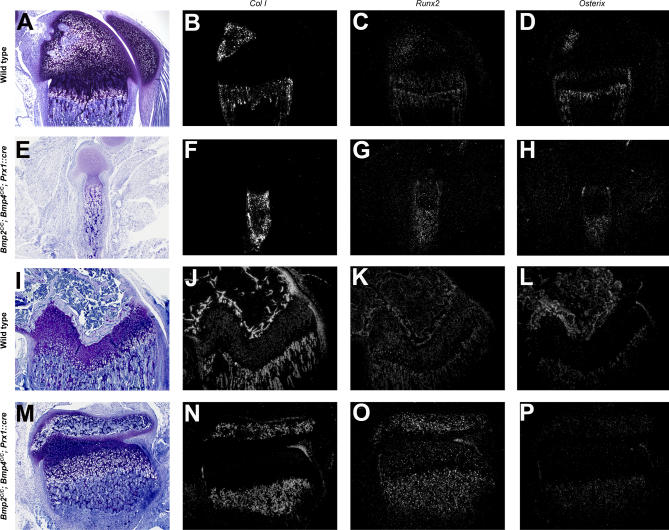
Osteoblast Maturation Is Inhibited in the Absence of BMP2 and BMP4(A–D) Distal femurs from control mice at 1 wk of age.(E–H) Distal femurs from Bmp2C/C; Bmp4C/C; Prx1::cre mice at 1 wk of age.(I–L) Distal femurs from control mice at 3 wks of age.(M–P) Distal femurs from Bmp2C/C; Bmp4C/C; Prx1::cre mice at 3 wks of age.In situ hybridization of early osteoblast differentiation-related marker genes Col I (B, F, J, and N), runx2 (C, G, K, and O) and osterix (D, H, L, and P).